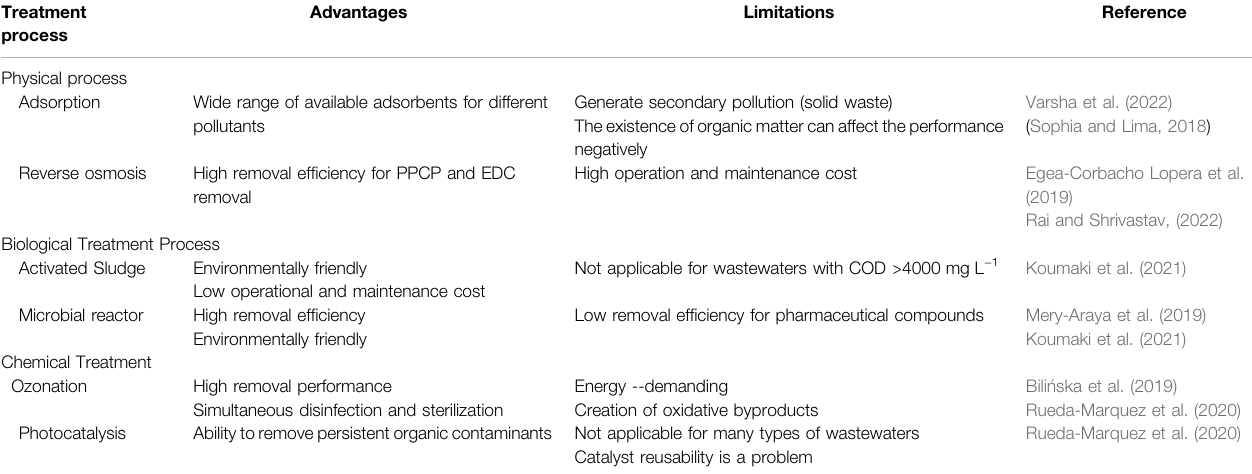
TABLE 1 | Advantages and challenges of treatment procedures for ECs removal.